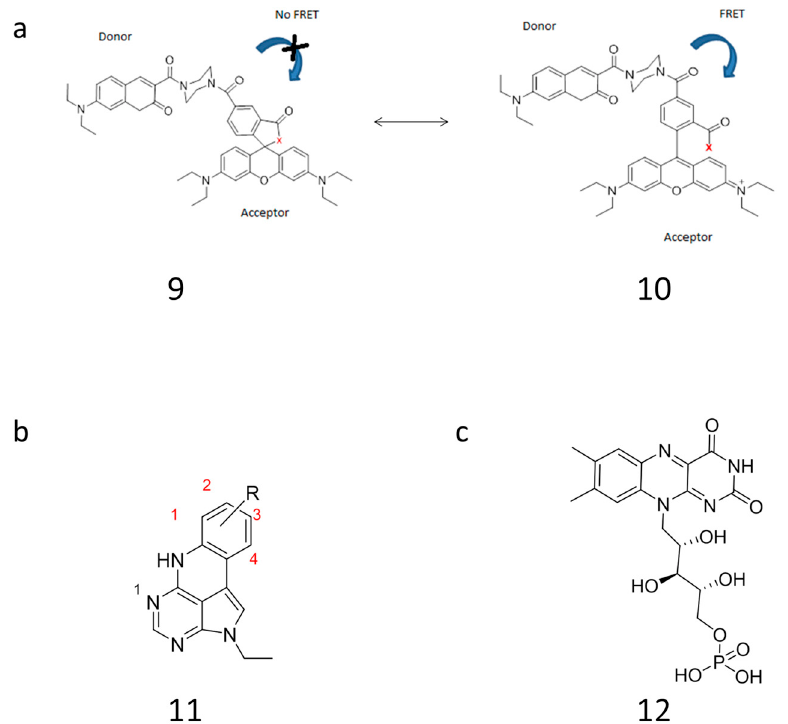
Figure 6. Computational design of new FRET dyes: ( a ) Rhodamine undergoes a very characteristic absorption change between the ring opening and the ring-closing conformation. Yuan et al. improve this mechanism for imagining of small molecular targets such as Cu 2+ , NO, HOCl by separation of the interaction site (denoted x) and the energy donor [103]; ( b ) Quadracyclic adenine analogues with the different substituents, R, was introduced by Larsen et al. Adenine analogues substituted at position 1 and 2 with cyanogroups showed a stable fluorescence quantum yield and environment-sensitive emission. Both properties make them suitable for monitoring nucleic acids systems [104]. R: fluorine-, methoxy- and cyanogroups; ( c ) Molecular structure of flavin mononucleotide (FMN) [105]. Fluorescent nucleobase analogues are other possible FRET donors and acceptors